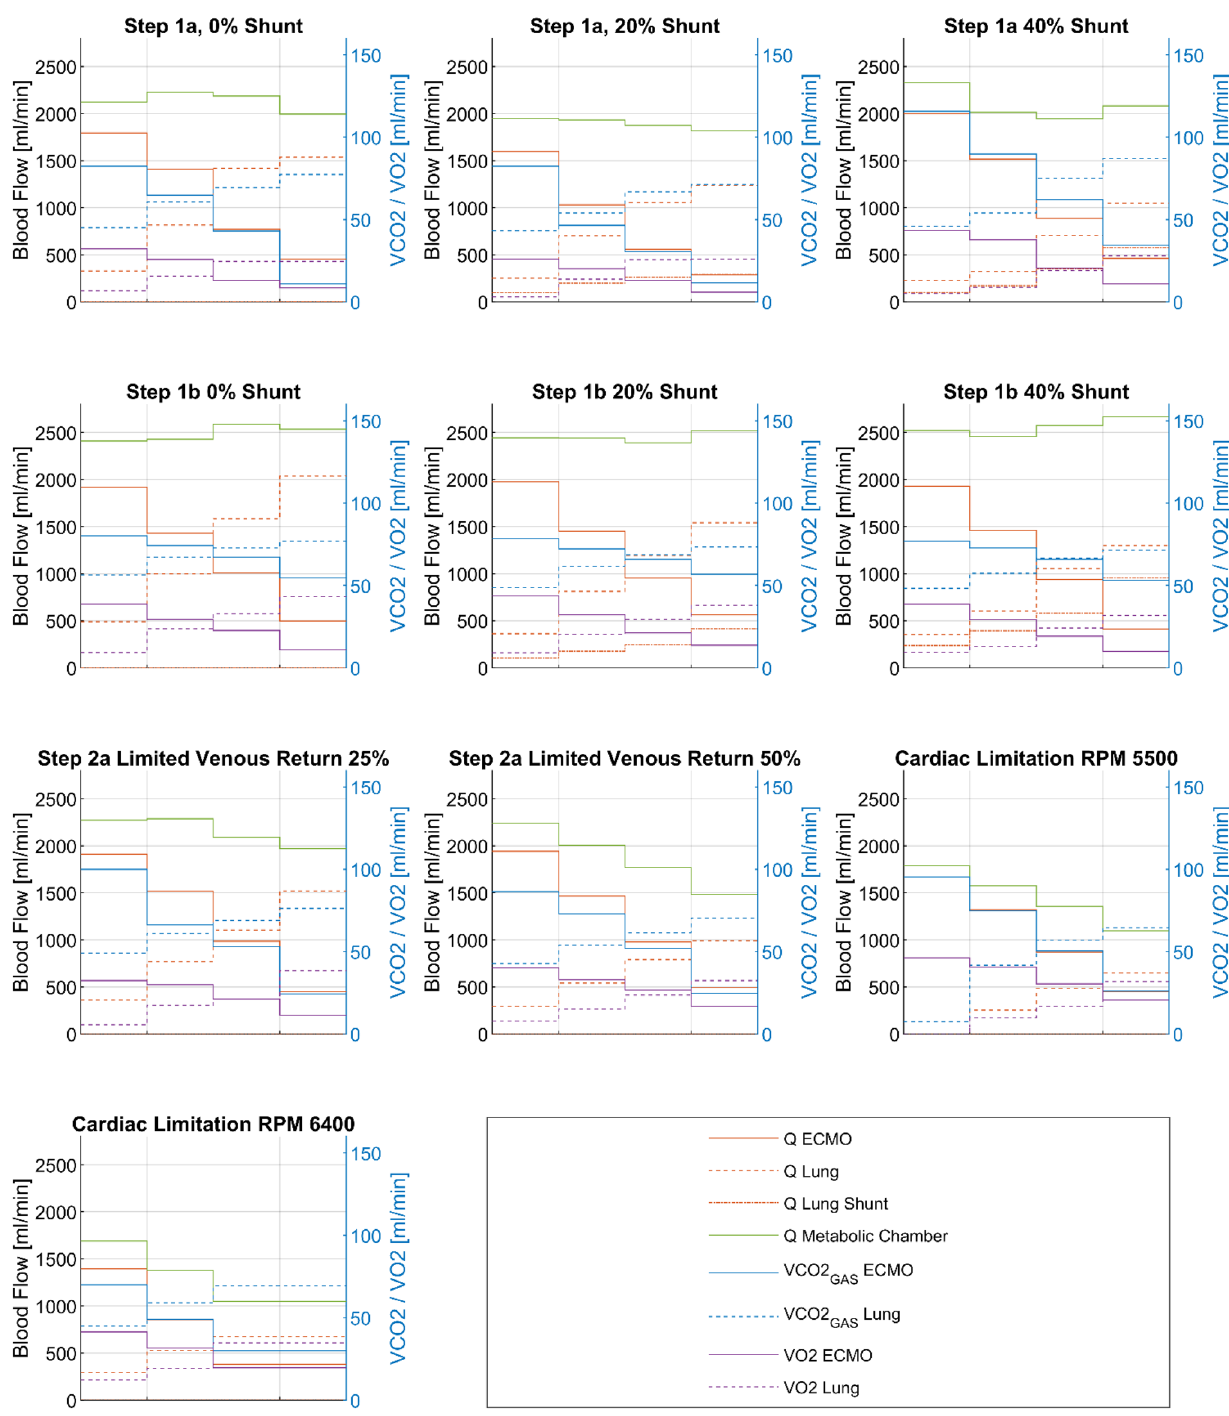
Figure 3. Stairs plot showing measured data from performed experiment with manoeuvres Step 1a, Step 1b, Step 2a and Step 2b. Note that in Step 2b, Cardiac Limitation there only 3 data points due to pump